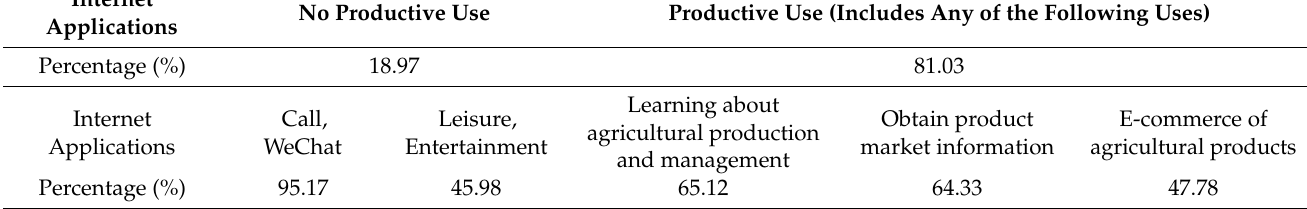
Table 1. Internet use of professional